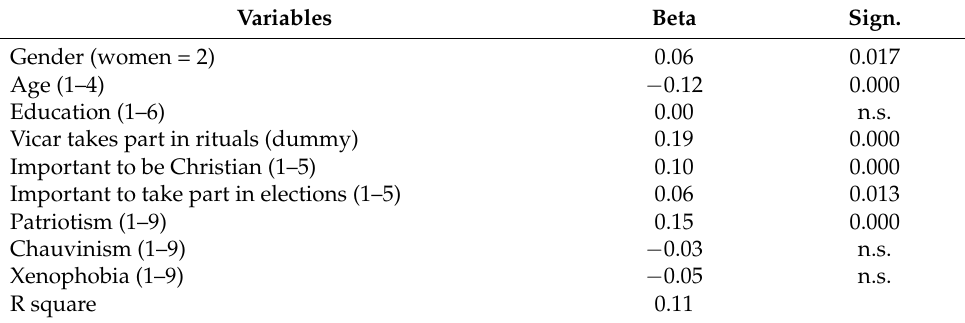
Table 5. Regression analysis of the singing of the National anthem on National Day (Beta and r square). N =